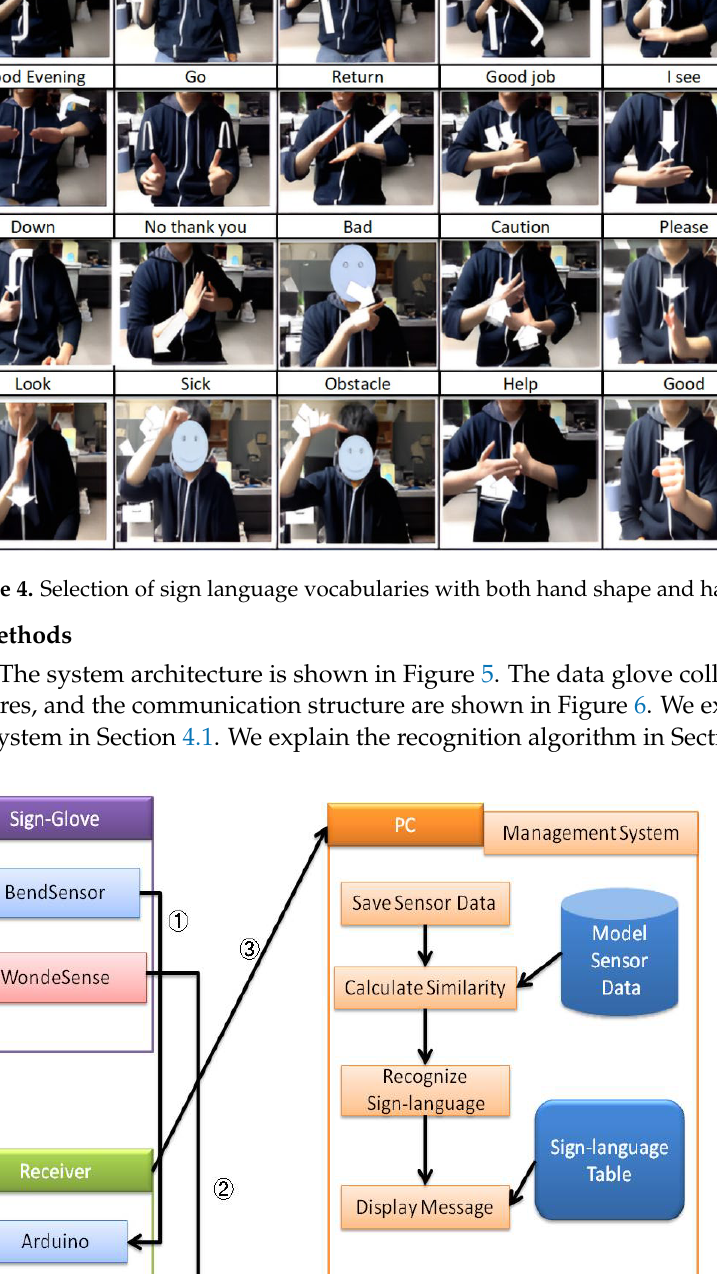
Figure 6. ( a ) System structure diagram; ( b ) IMU collecting the hand motion data; ( c ) bending sensor collecting the hand shape data. 3.1. System Design In this section, we explain how a sign language word is recognized by the system constructed in this research and the way to detect it. First of all, we explain the operation of this system. This research system recognizes a sign language word based on bending condition data of fingers detected by a bending sensor and acceleration data of hands de- tected by WonderSense. First, the Sign-Glove worn on a user’s hands takes bending fingers condition data and acceleration data of hands from the bending sensor and the 3-axis acceleration sensor.